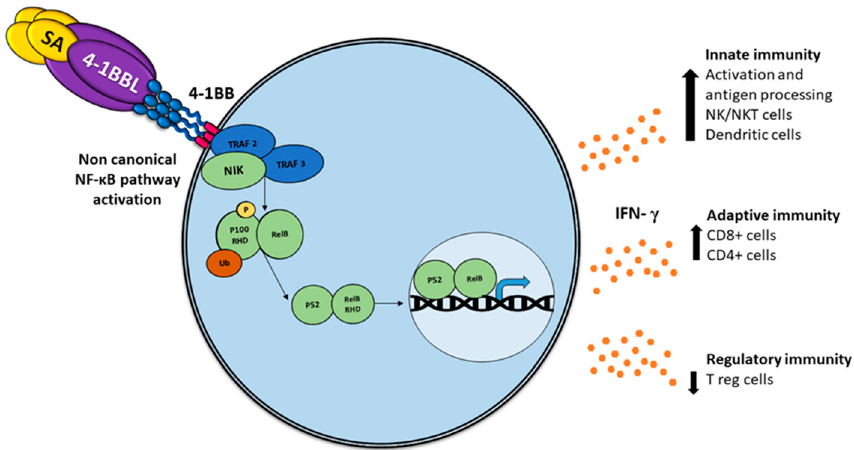
Figure 1. Activation of the non-canonical NF- κ B pathway by SA-4-1BBL through the tumor necrosis factor receptor (TNFR) includes the slow and persistent activation of the NF- κ B-inducing kinase (NIK), phosphorylation of NIK-mediated p100, and subsequent nuclear processing and translocation of p100 from p52 and RELB, with the consequent production of interferon (IFN), which triggers pleiotropic effects on the immune